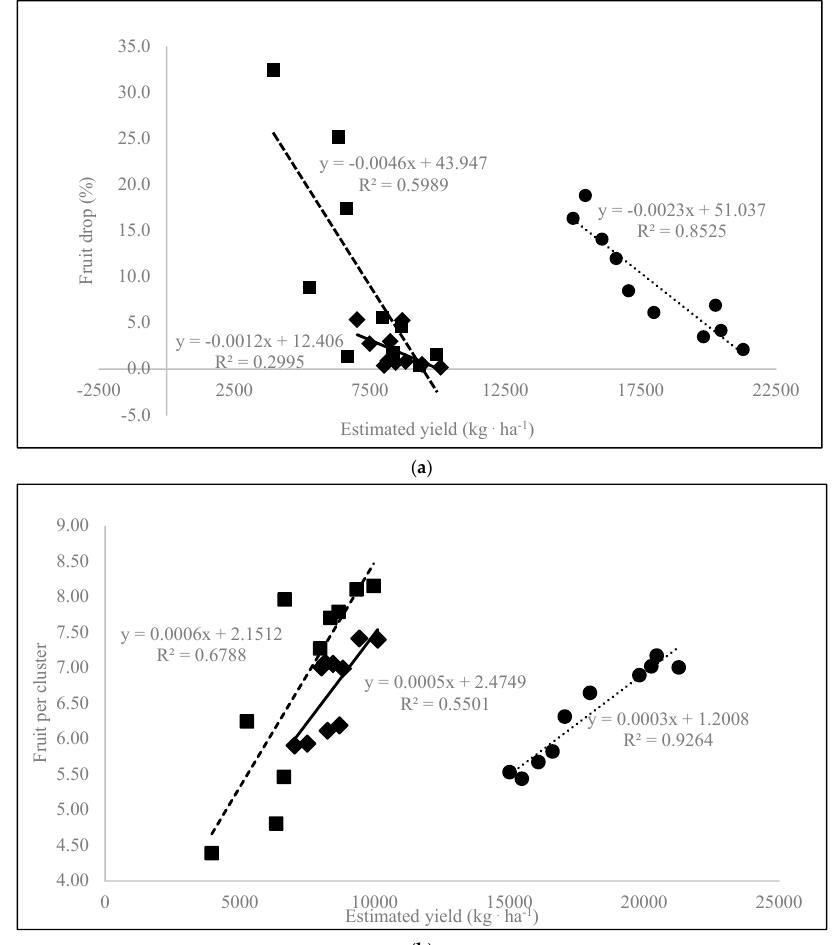
Figure 2. XY plots with regression equations and coefficients of determination between plant responses as affected by foliar Ca applications to ‘Draper’ highbush blueberry across three farm sites in the Fraser Valley, British Columbia, Canada in 2016 ( a ) Percent fruit drop versus estimated yield; ( b ) Fruit per cluster versus estimated yield, ● = Site 1 (do tt ed line), ◼ = Site 2 (dashed line), ◆ = Site 3 (solid line).